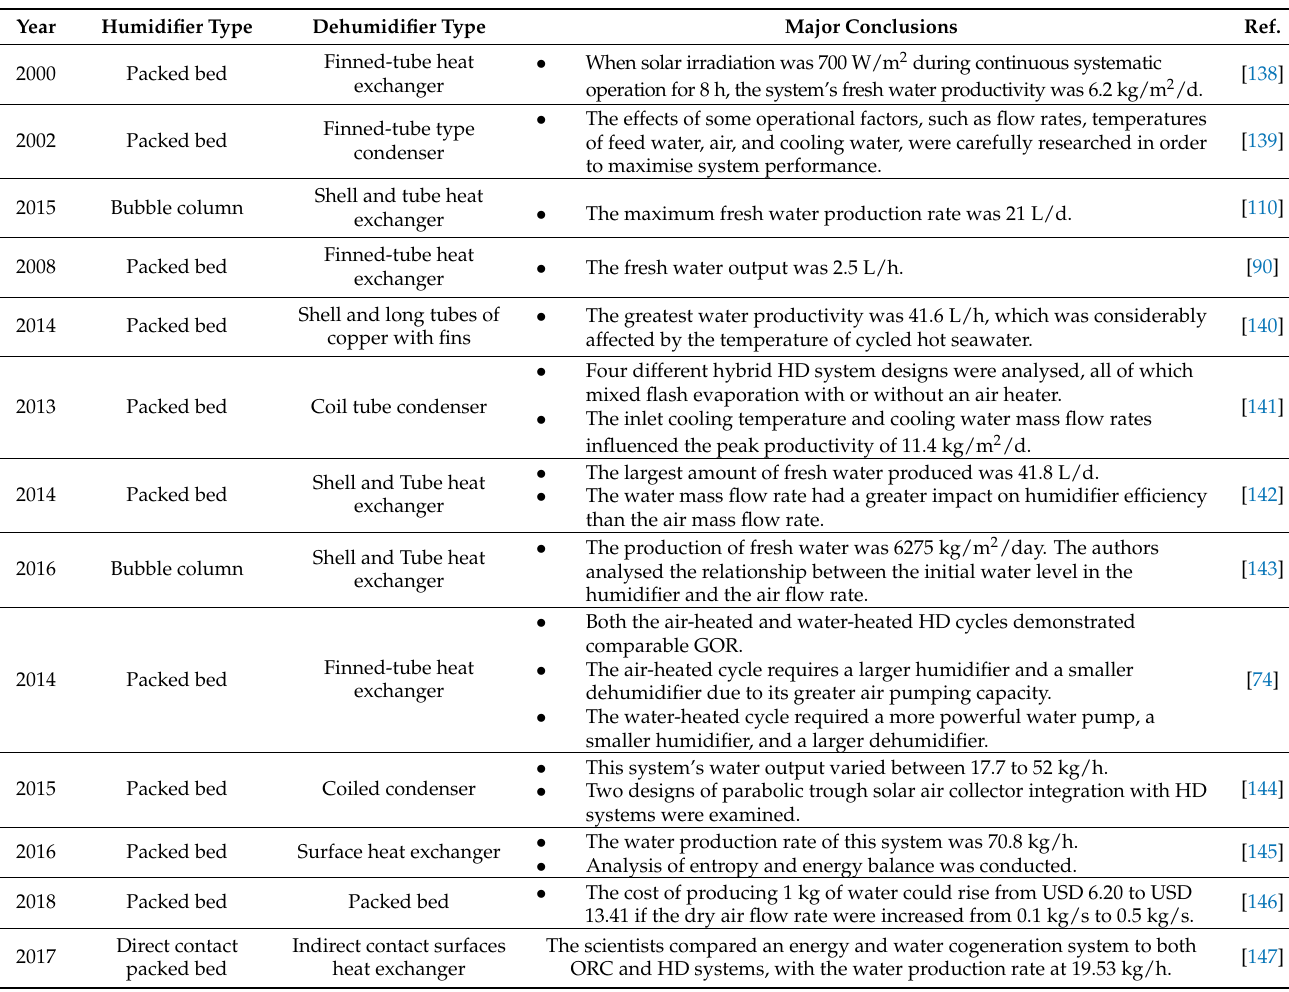
Table 3. Experimental HD and humidifier/dehumidifier